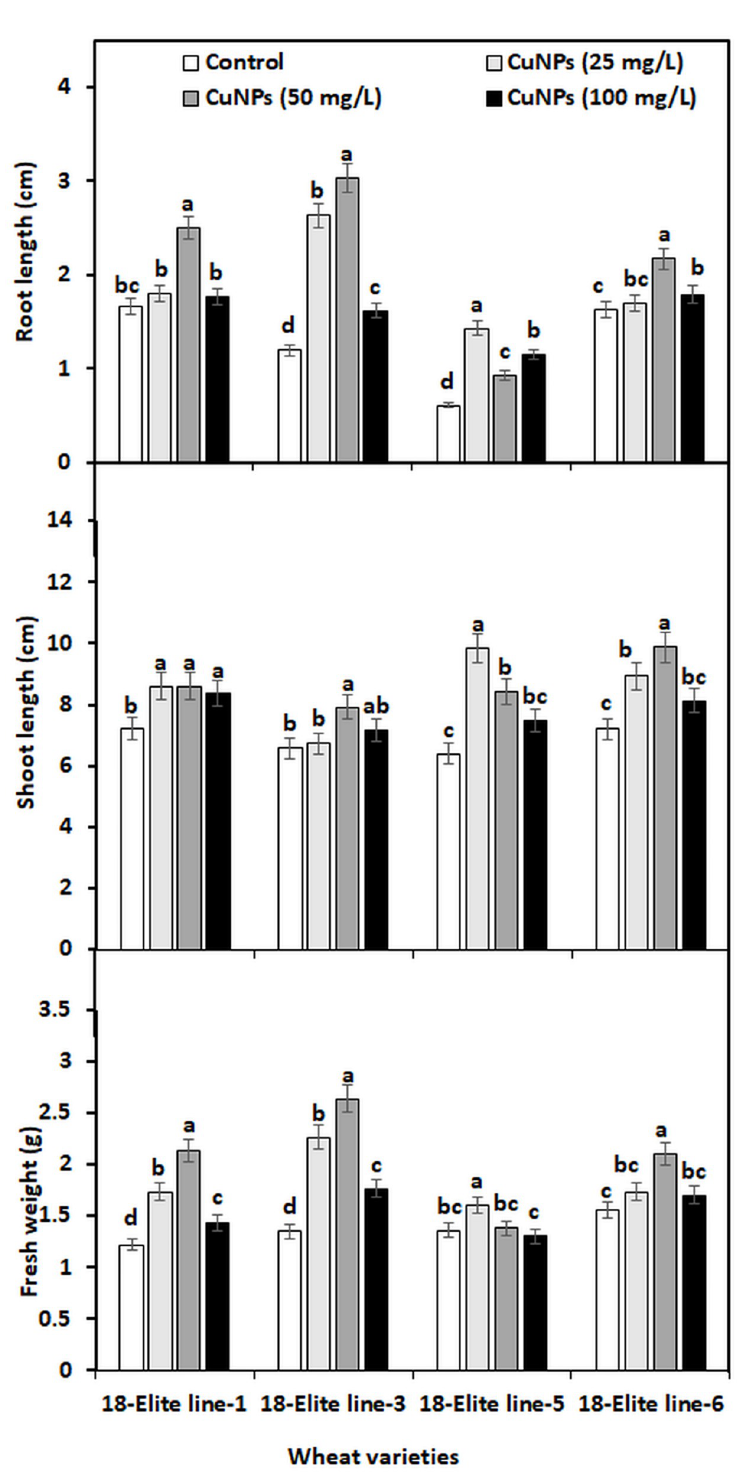
Fig 5. Root length, shoot length, and fresh weight of 10 days wheat seedlings affected by different concentration of CuNPs. Different letters in the same sub-group of columns indicate significant difference at p < 0.05 level.